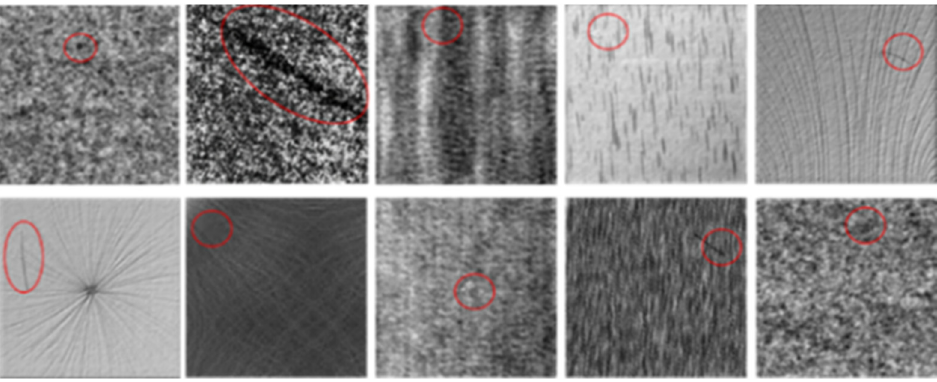
Figure 4. Defects detect data set.